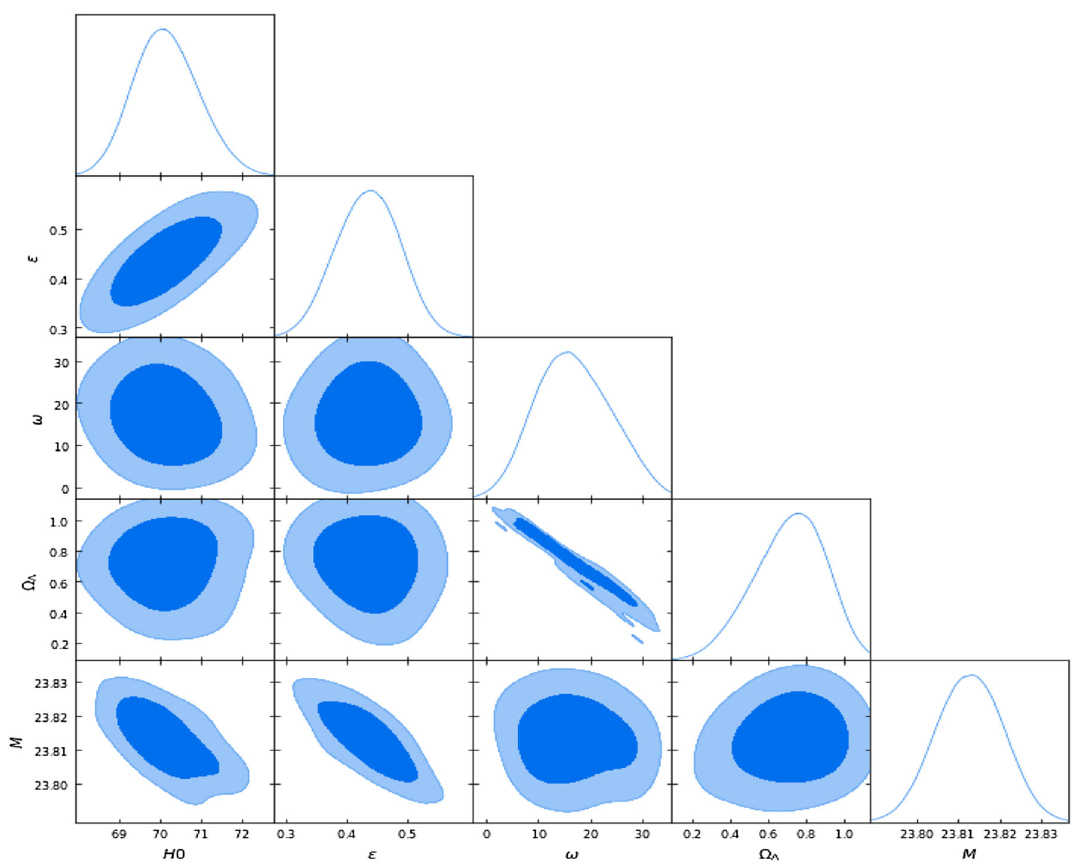
Fig. 3 One dimensional and two-dimensional marginalized confidence regions for the model parameters of Λ H 2 from DS1 data